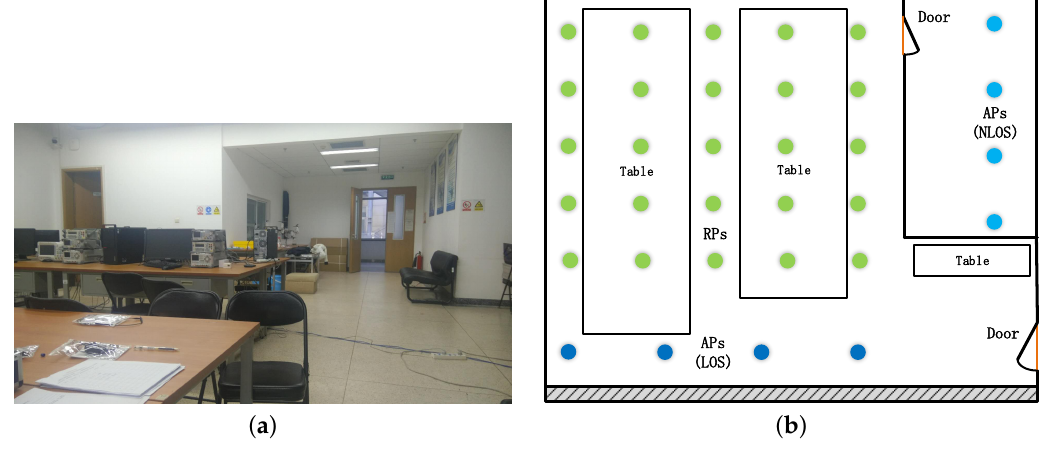
Figure 2. ( a ) Photo of the office. ( b ) Layout of a part of the